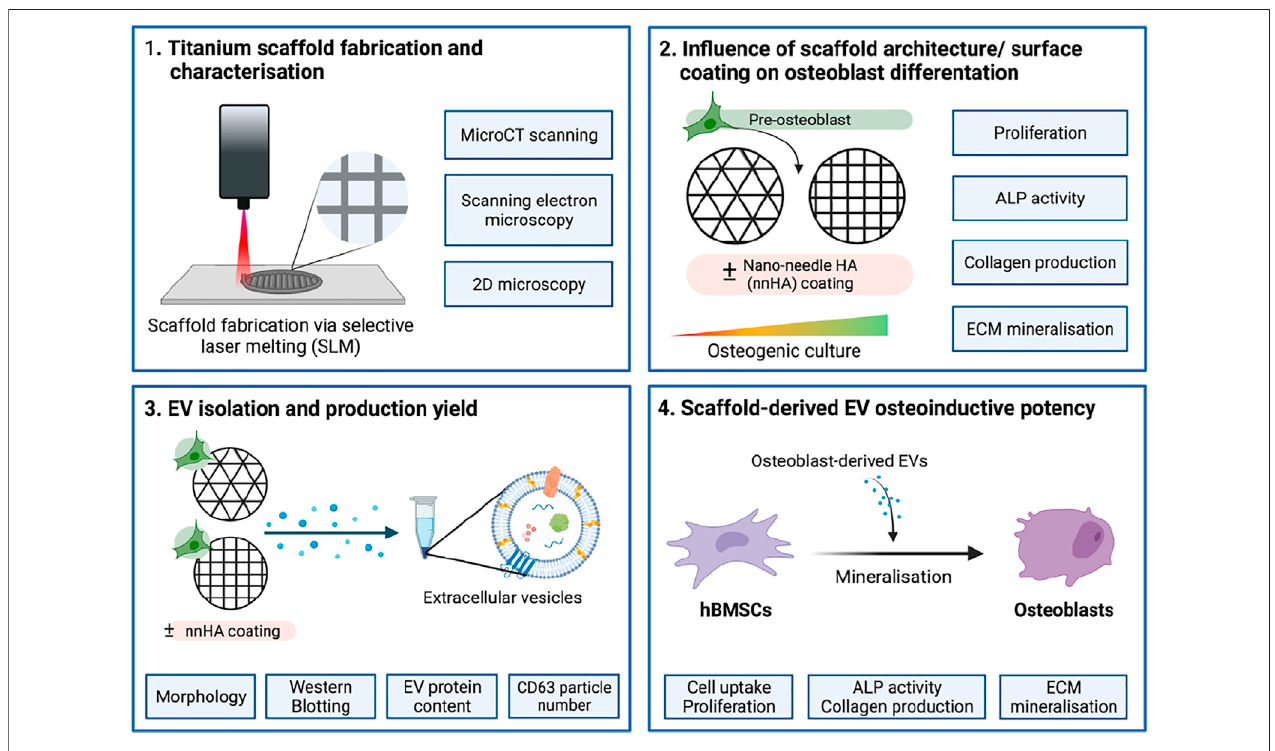
FIGURE1| Schematicrepresentationofstudydesign. 1) TitaniumscaffoldswereprintedusingSLMandtheirstructureandtopographywerecharacterised. 2) The effects of scaffold architecture and surface coating on osteoblast mineralisation were evaluated. 3) EVs were isolated from scaffold-cultured osteoblasts and characterised. 4) Theosteoinductivepotencyofscaffold-derivedEVsonstimulatinghBMSC ’